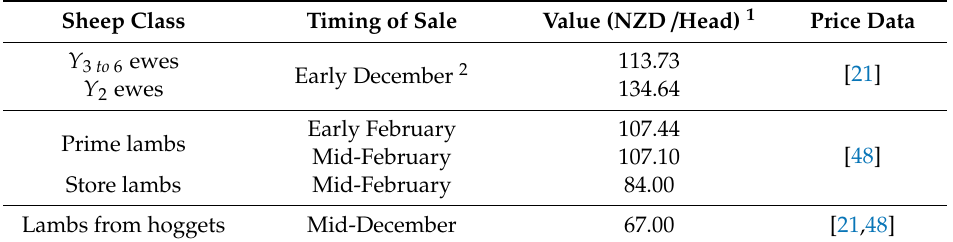
Table 1. Prices for sold sheep in 2017 / 18, ewes of various age classes (Yi), and lambs sold either prime (direct to slaughter) or store (to another farmer to grow for slaughter), with lambs from hoggets sold store after their